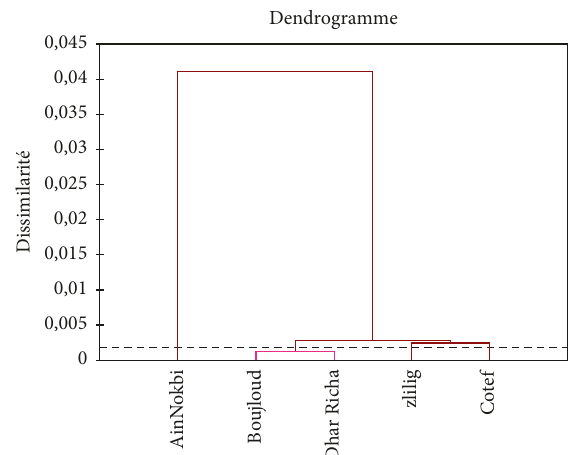
Figure 5: Dendrogram of the classification of the study sites.